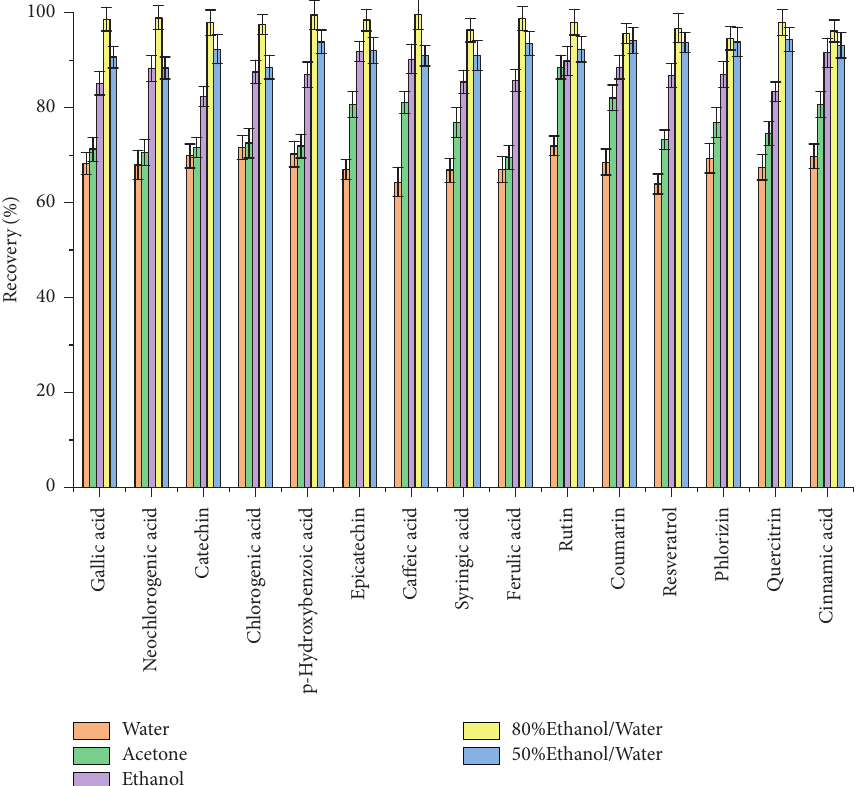
Figure 2: Effect of extraction solvent type on the ER% of polyphenols.